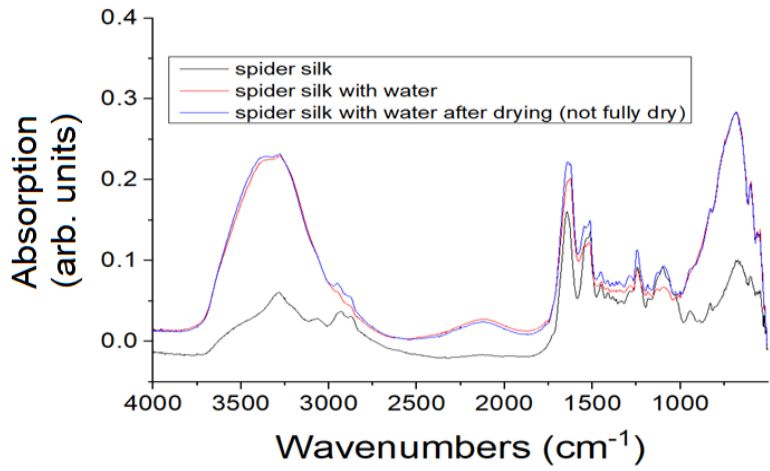
Figure 4. FTIR spectrum of spider silk nanofibers showing the formed chemical bonds corresponding to beta-sheets, with increased number of peaks due to the humid environment.